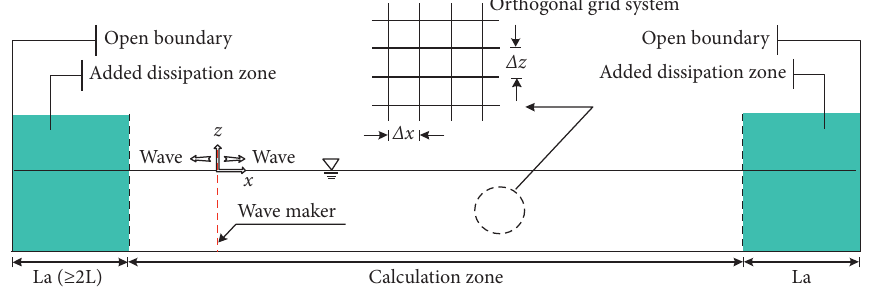
Figure 4: Schematic diagram of the numerical wave tank used in the 2D-NIT